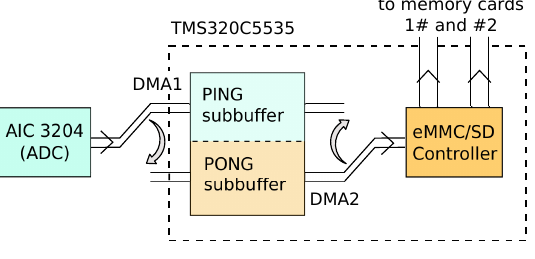
Figure 2. Block diagram detail of the Ping-Pong